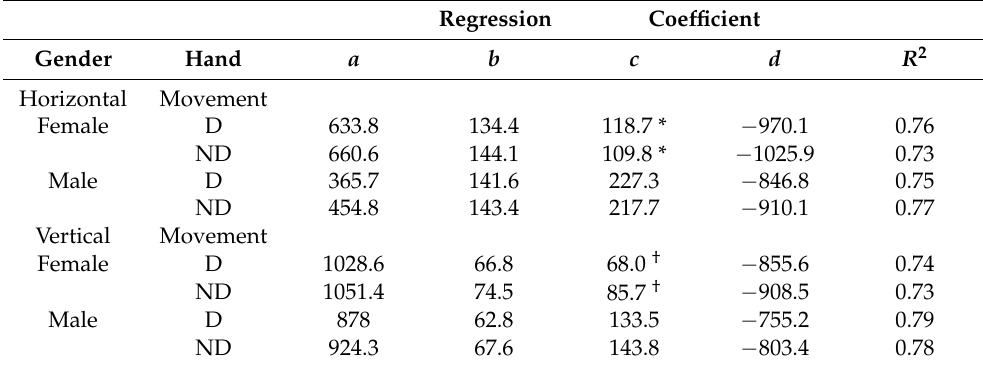
( b ) Figure 6. MT of female ( a ) and male ( b ) participants performing the vertical pointing task.